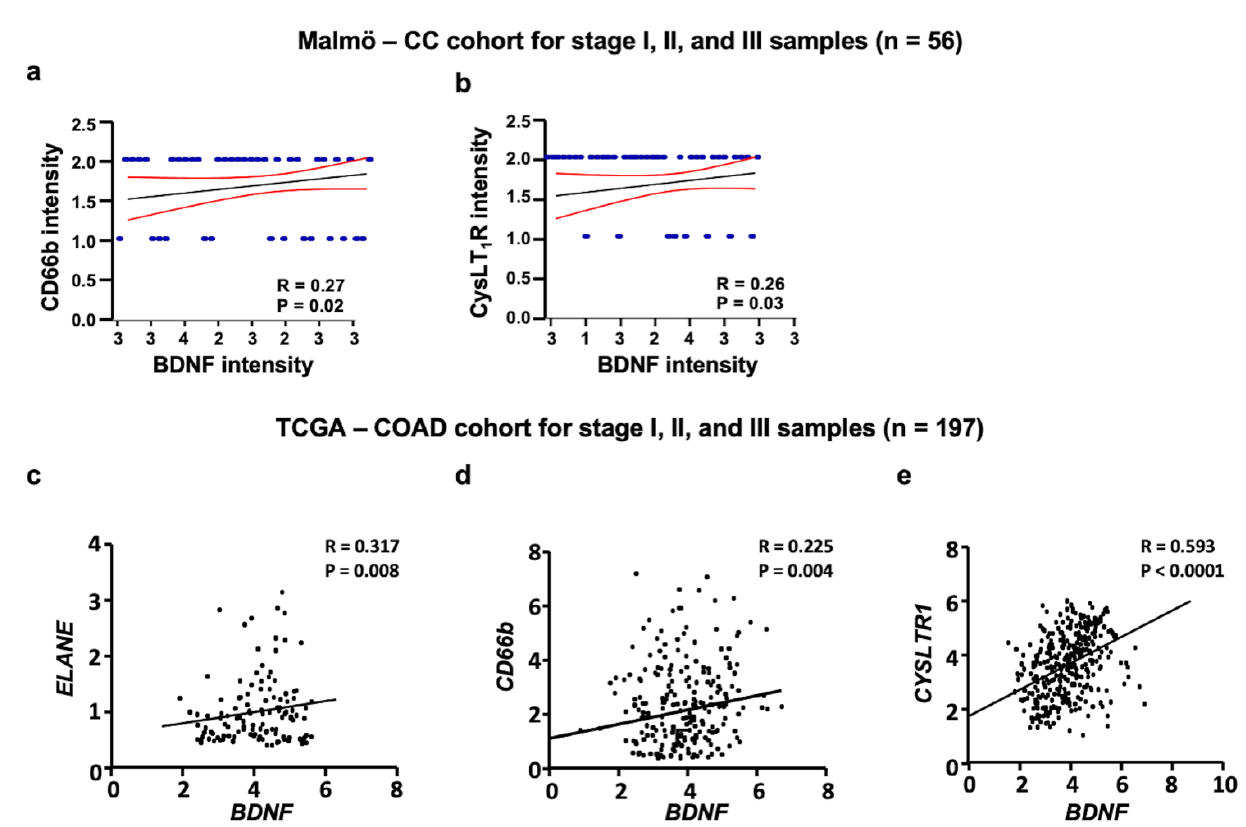
Figure 2. BDNF and CysLT 1 R positively correlates in colon cancer patients. ( a , b ) Spearman Correlation of BDNF expression with ( a ) CD66-positive (CD66b + ) neutrophil expression and ( b ) CysLT 1 R. ( c – e ) XY scatter plot of BDNF mRNA levels with ( c ) ELANE , ( d ) CD66b and ( e ) CYSLTR1 in TCGA-COAD cohort.